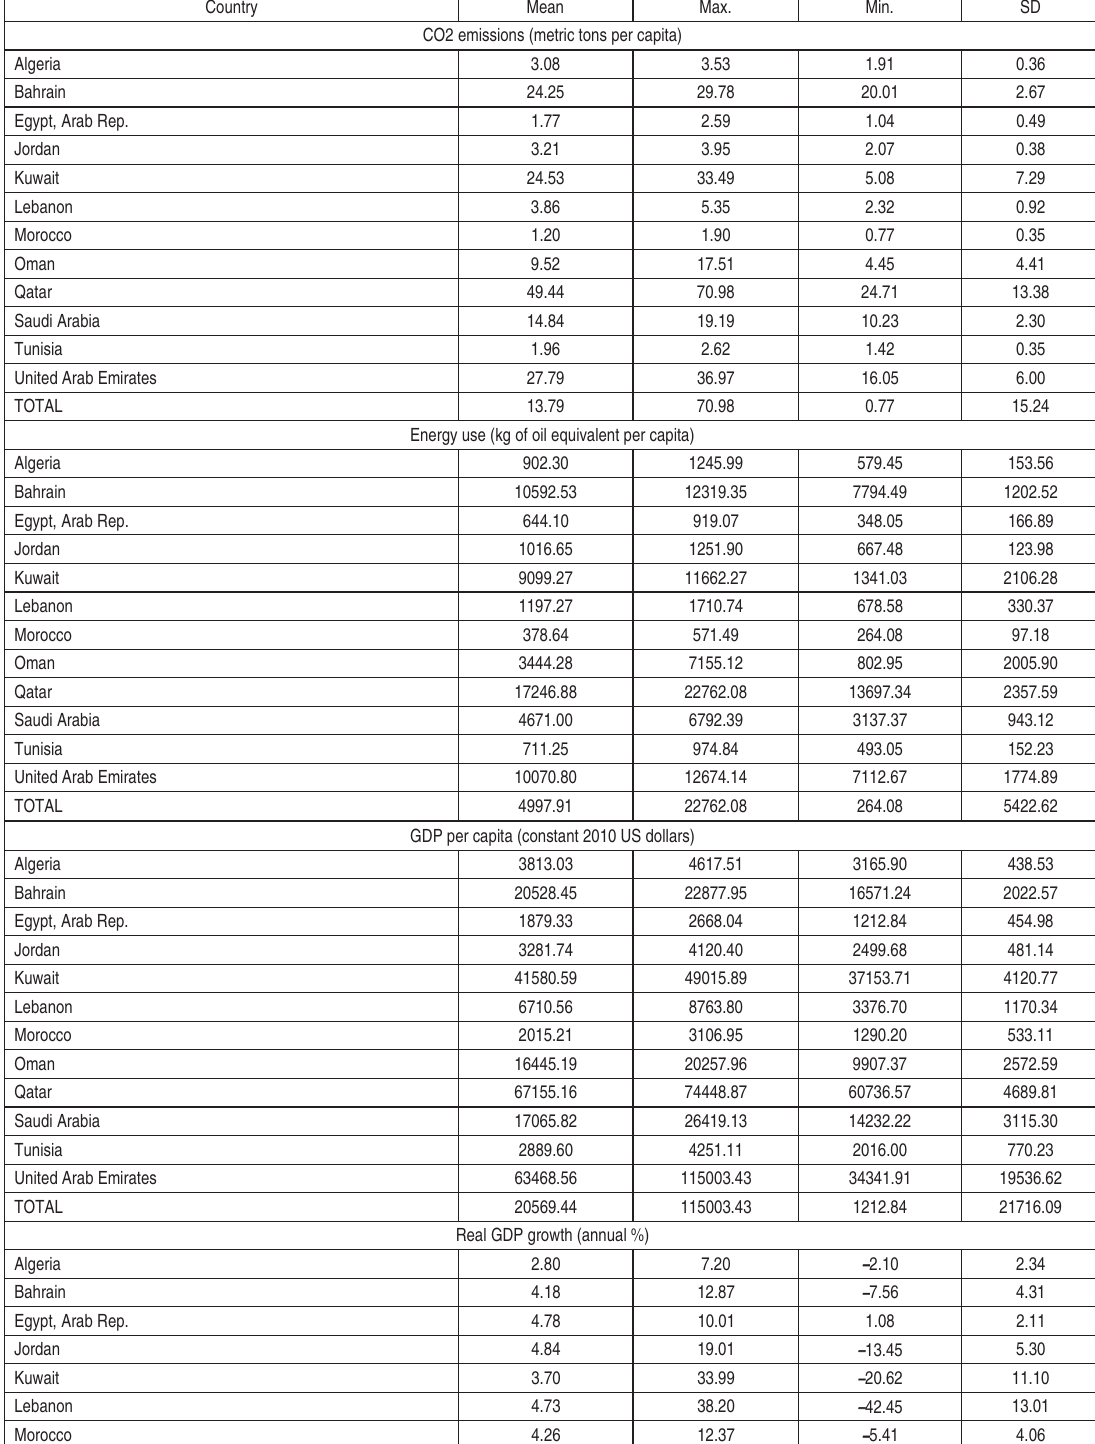
Table A.1. Summary Statistics of key variables over